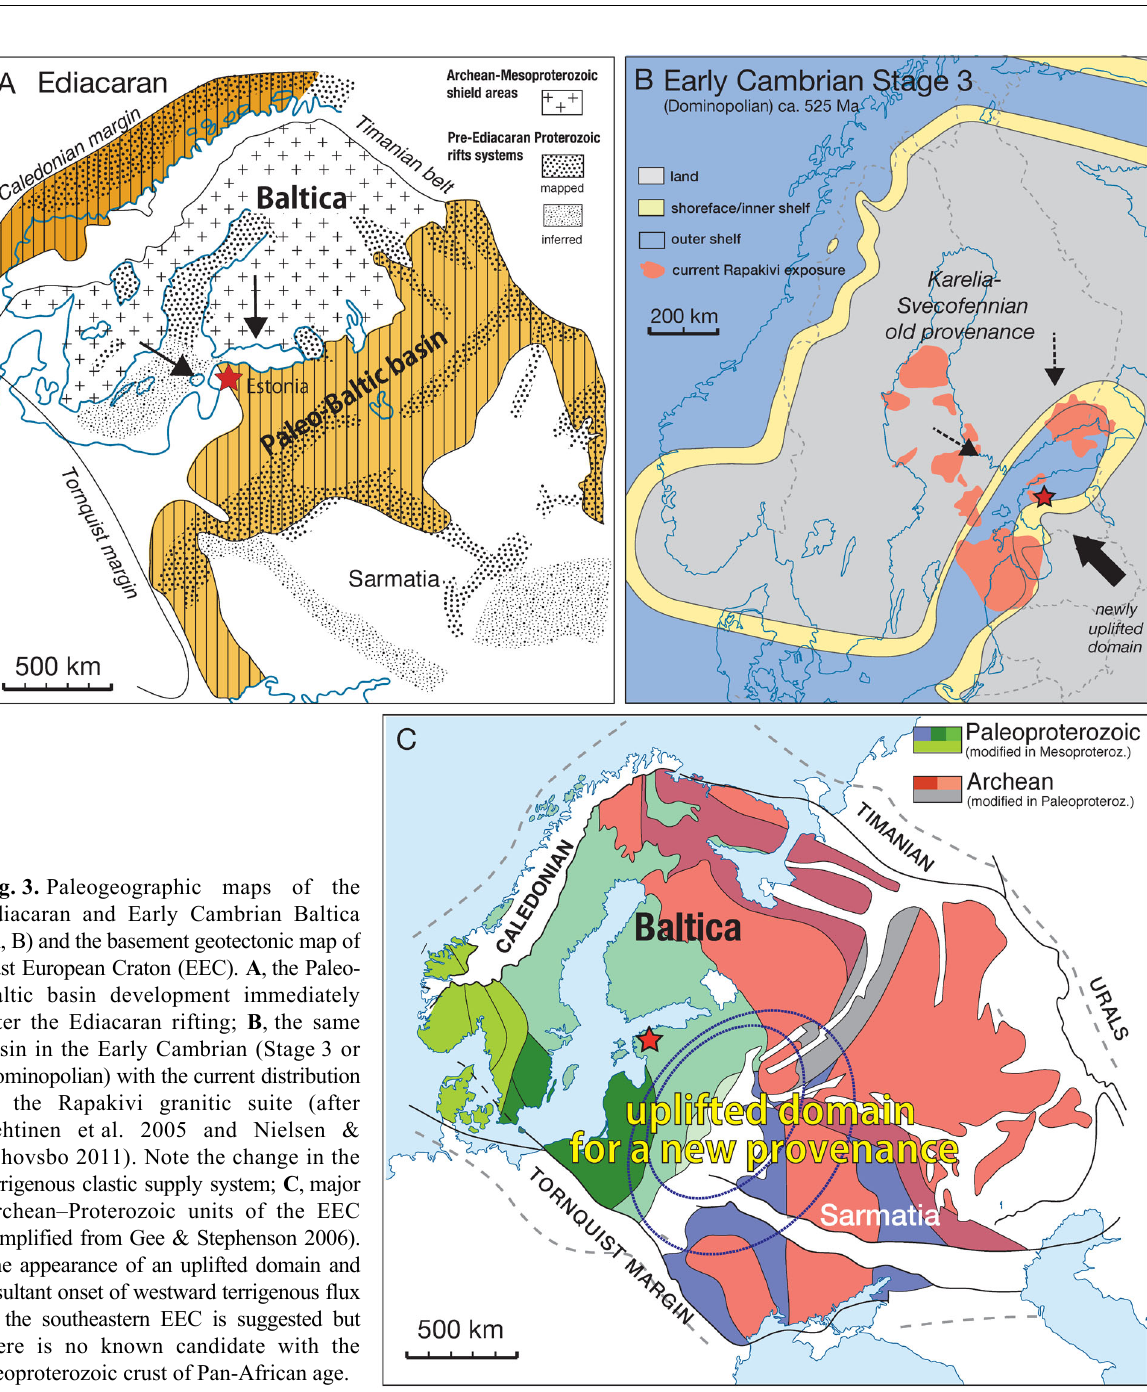
Fig. 3. Paleogeographic maps of the Ediacaran and Early Cambrian Baltica (A, B) and the basement geotectonic map of East European Craton (EEC). A , the Paleo- Baltic basin development immediately after the Ediacaran rifting; B , the same basin in the Early Cambrian (Stage 3 or Dominopolian) with the current distribution of the Rapakivi granitic suite (after Lehtinen et al. 2005 and Nielsen & Schovsbo 2011). Note the change in the terrigenous clastic supply system; C , major Archean(cid:150)Proterozoic units of the EEC (simplified from Gee & Stephenson 2006). The appearance of an uplifted domain an d resultant onset of westward terrigenous flux in the southeastern EEC is suggested but there is no known candidate with the Neoproterozoic crust of Pan-African